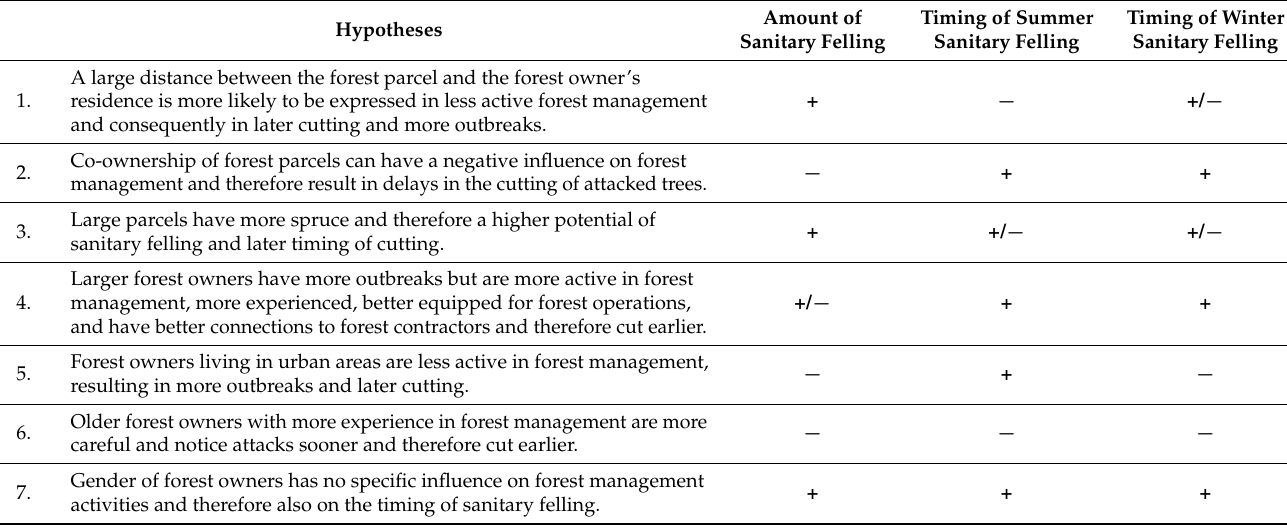
Table 4. Confirmation (+), partial confirmation (+/ − ), or rejection ( − ) of the hypotheses on the influence of forest owner characteristics on bark beetle management according to the